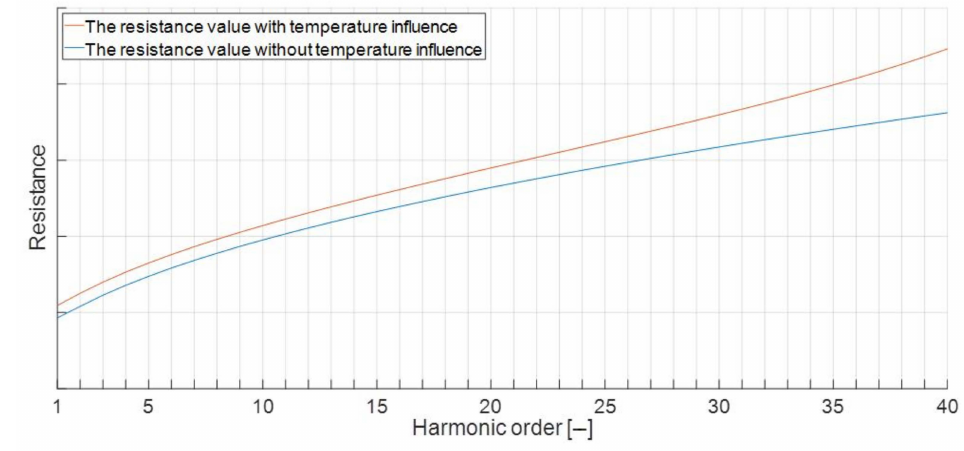
Figure 2. The harmonic order effect on the cable resistance